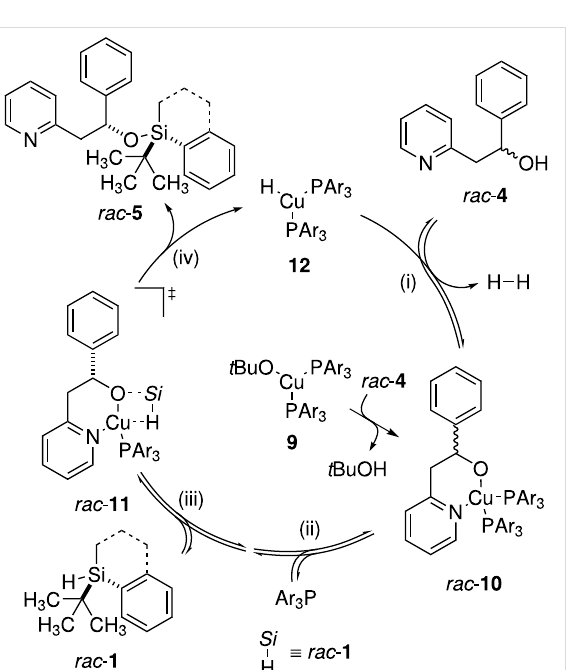
Scheme 4: Postulated catalytic cycle for dehydrogenative